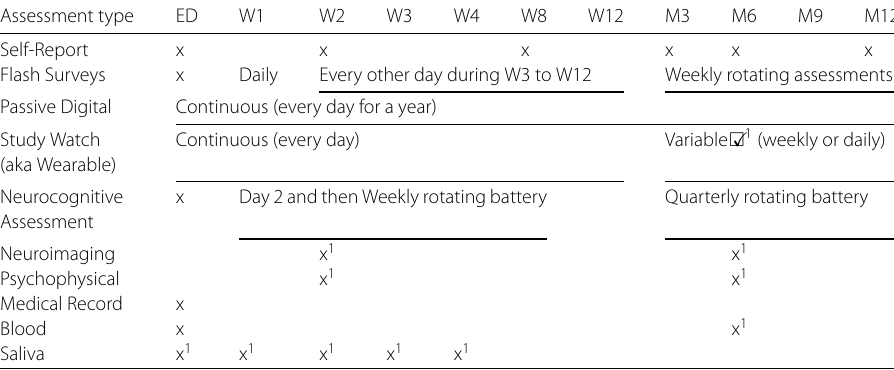
Thecombinationofdatacollectionsinvolvingsurveyandbigdatastreams.ED = emergencydepartment(i.e.,baselinedata); W = Weeklydata;andM = Monthly data. 1 Subsample